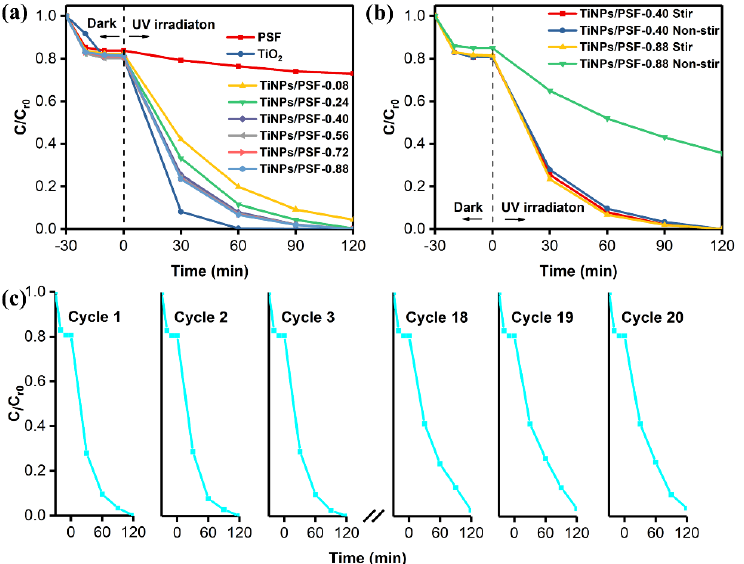
Figure 6. ( a ) Adsorption and photocatalytic experiment of methylene blue solutions with PSF, TiO 2